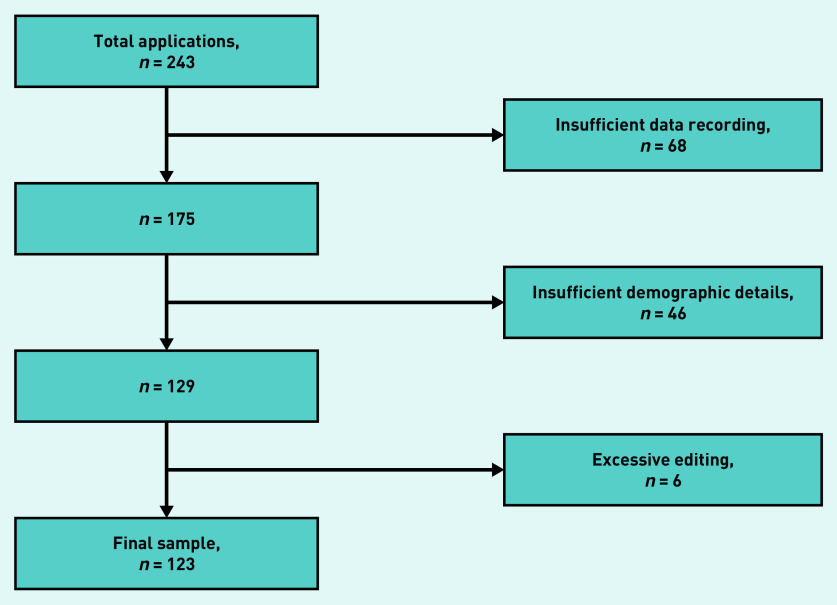
Flow chart demonstrating sample size following the application of exclusion criteria.